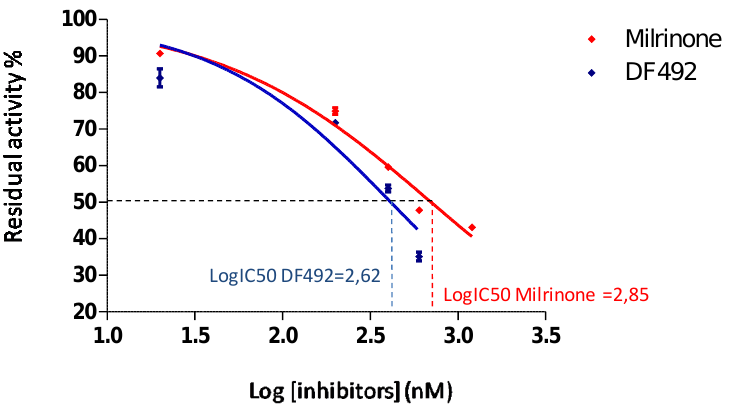
Figure 5. Non-linear regression evaluated by using a “dose-response inhibition” build-model to calculate the concentration of inhibitor that gives a response halfway between bottom and top (IC 50 ).